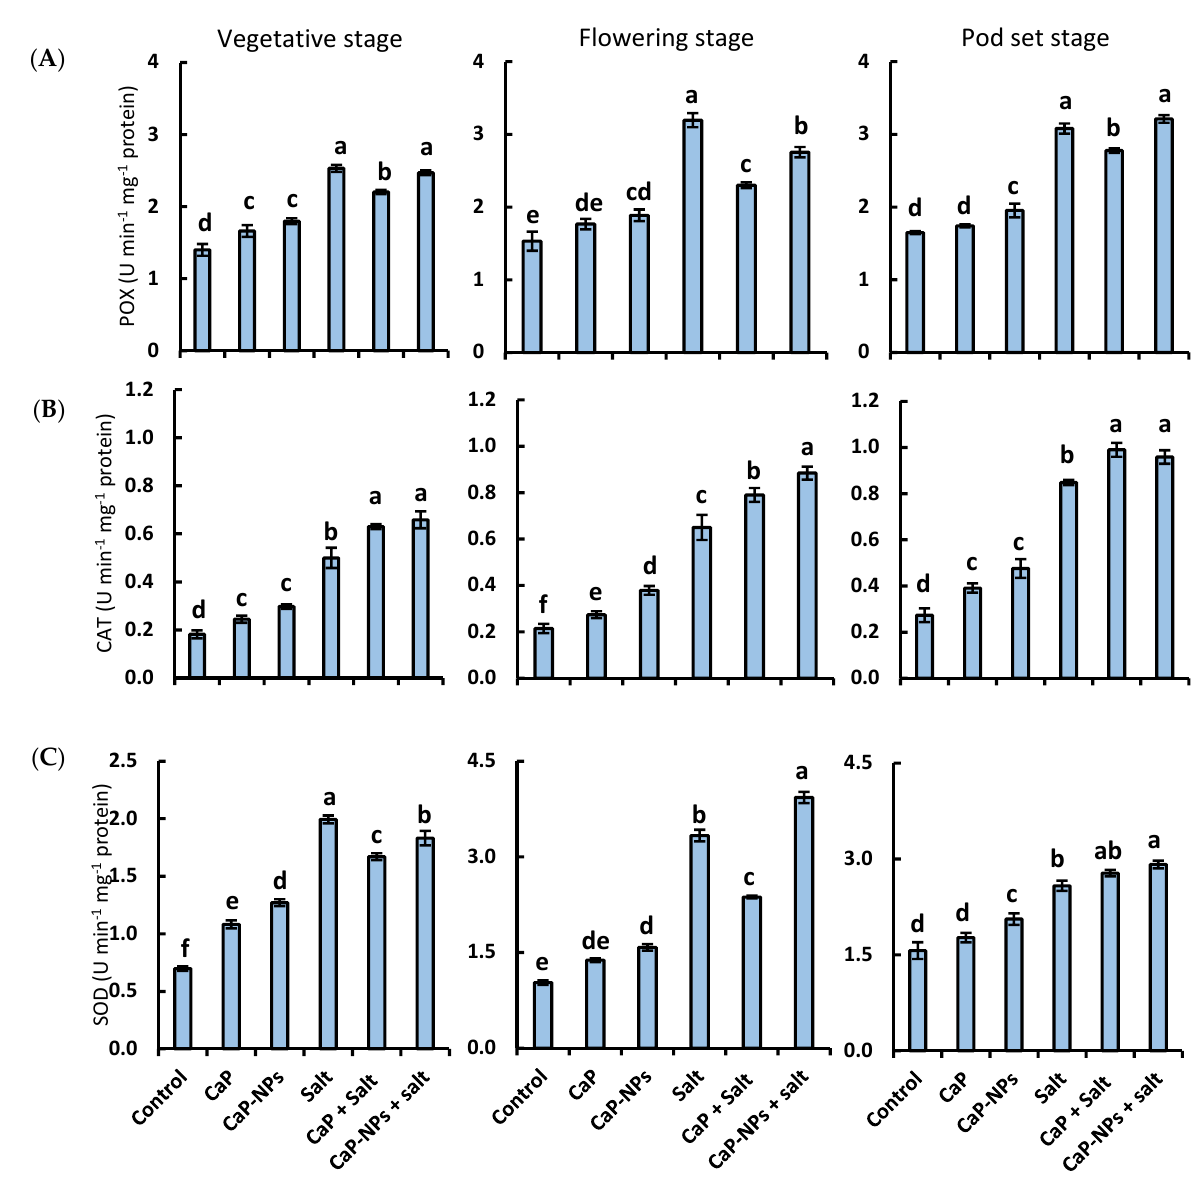
Figure 9. Effect of NaCl stress on ( A ) POX, ( B ) CAT, and ( C ) SOD of broad bean plants in 3 growth stages. The same letters indicate no significant difference ( p < 0.05) as analyzed by the Duncan test. Each value is the average of 3 replicates ± SE.